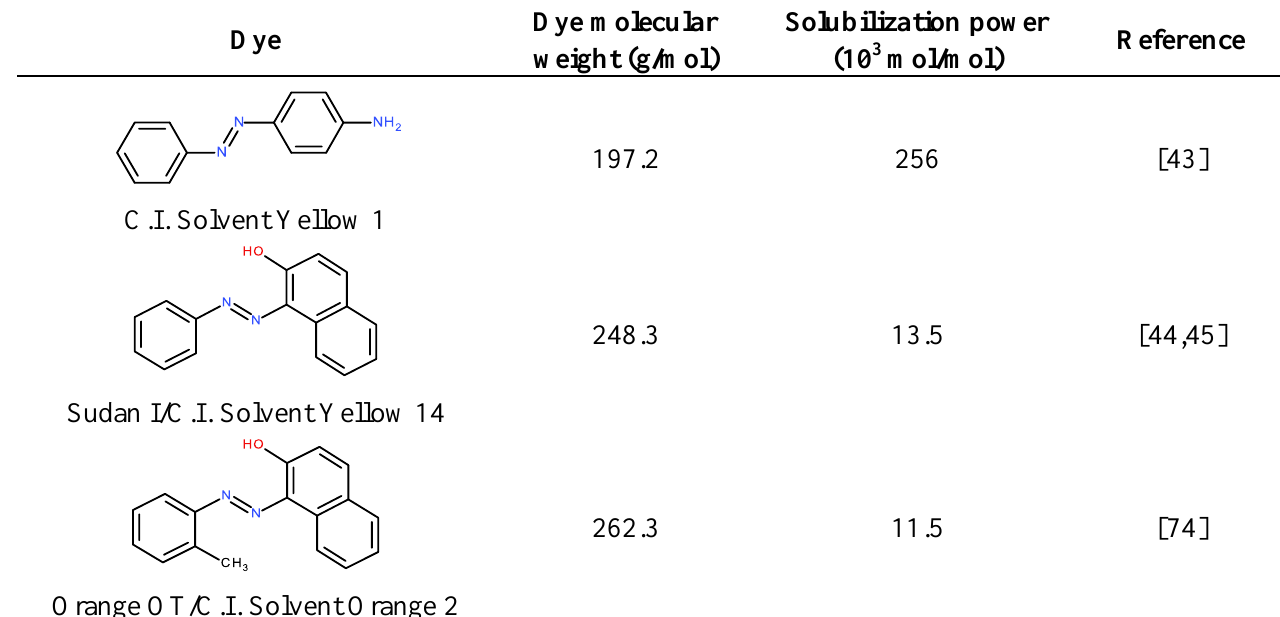
Table 2. Solubilization power of dodecyltrimethylammonium bromide (DTAB) for different water insoluble dyes at 23–25 